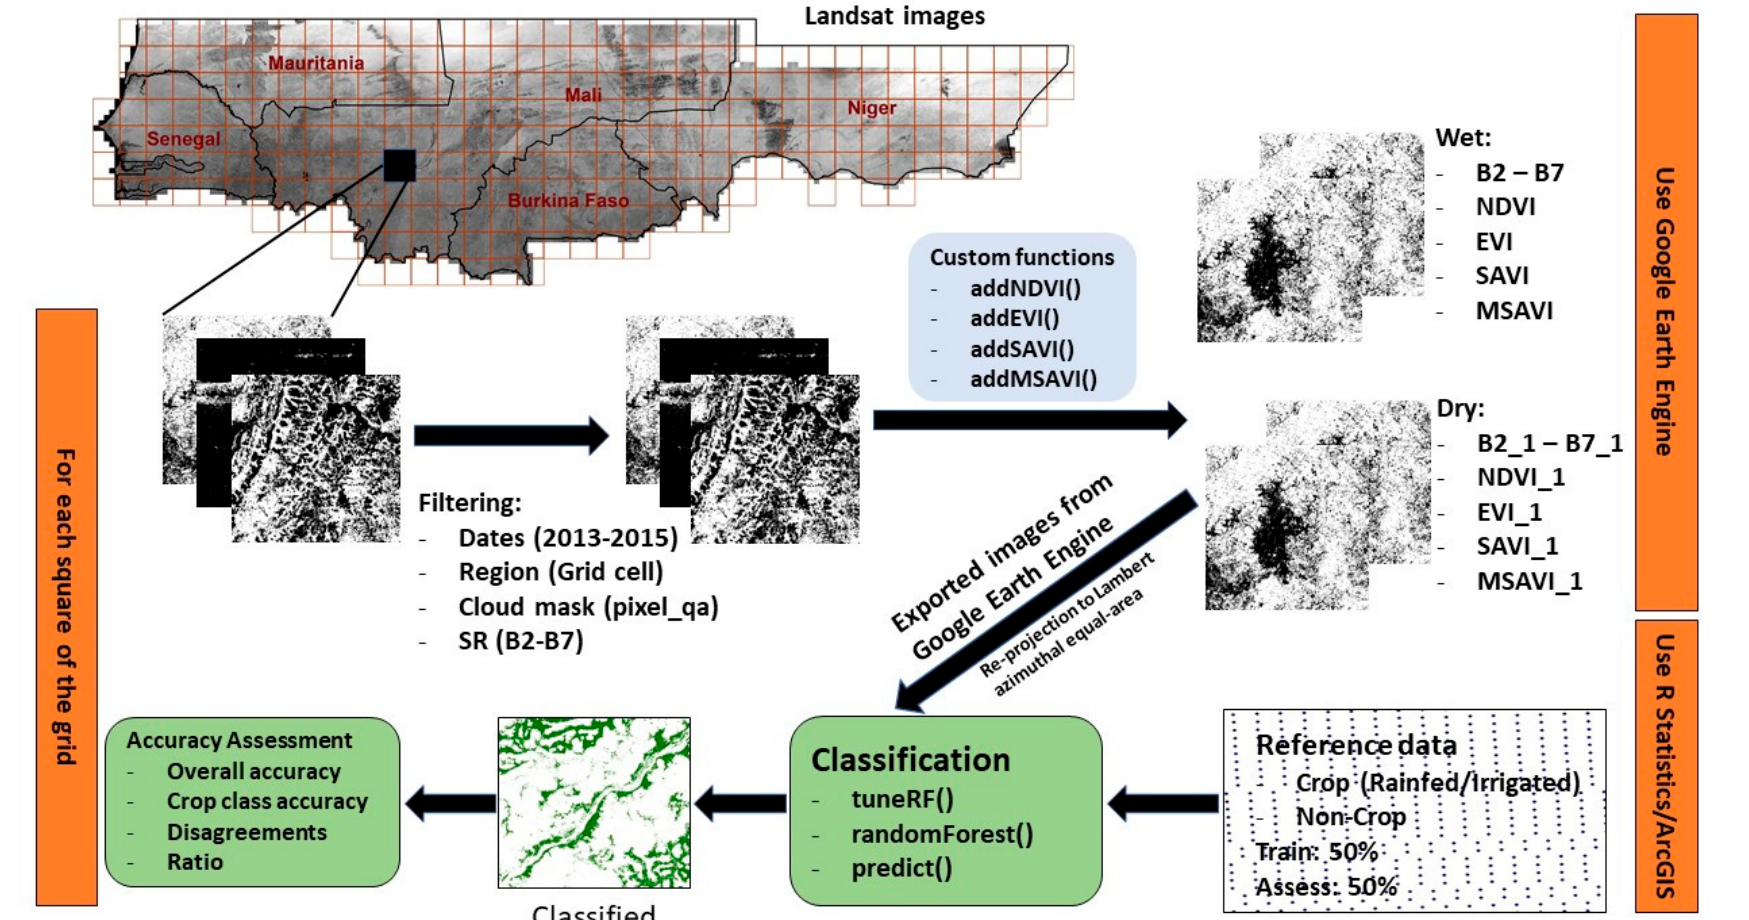
Figure 2. Workflow describing major steps of the cropland dataset development.